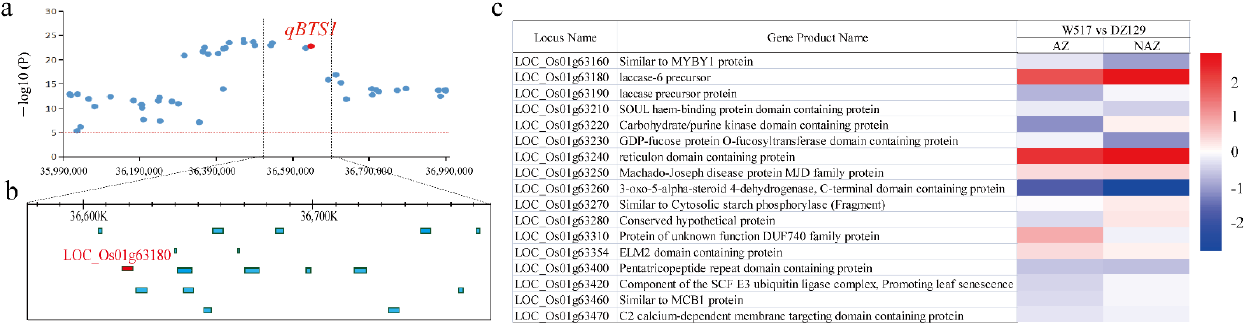
Figure 6. Identification of the candidate gene LOC_ Os01g63180: ( a ) Local Manhattan plot of BTS values surrounding the peak on chromosome 1. ( b ) Identification of candidate genes in the region of qBTS1 . ( c ) The candidate genes of qBTS1 and their expression patterns in the RNA-Seq results.